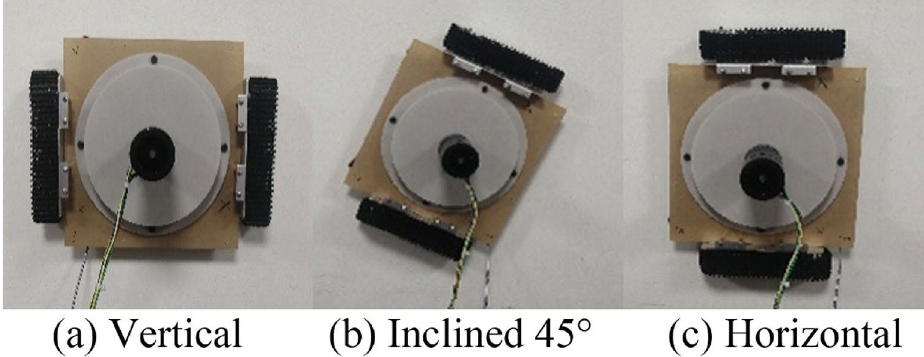
Figure 9. Three orientations of the robot.